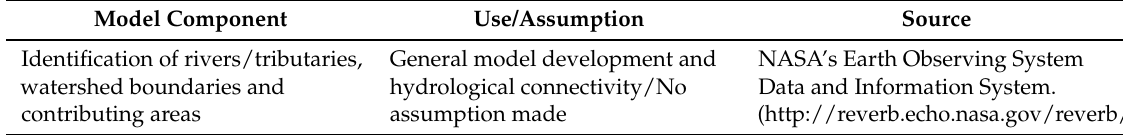
Table 2. Sources of digital data used for building the WEAP model for the Quiroz-Chipillico watershed. Model Component Use/Assumption Source General model development and NASA’s Earth Observing